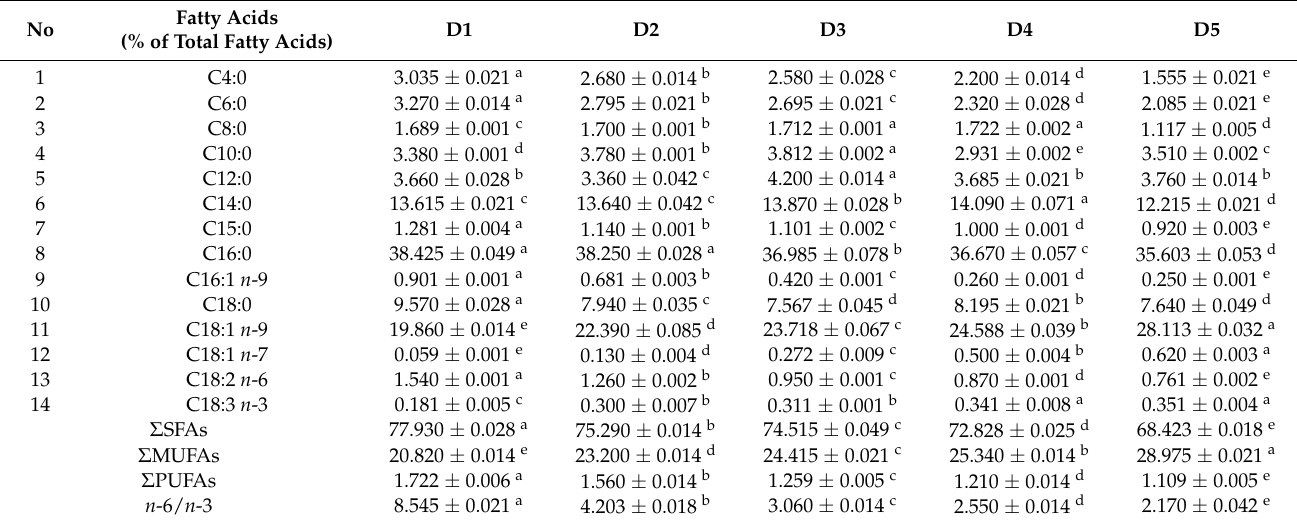
Table 4. Fatty acid composition (%) of Apuseni cheese